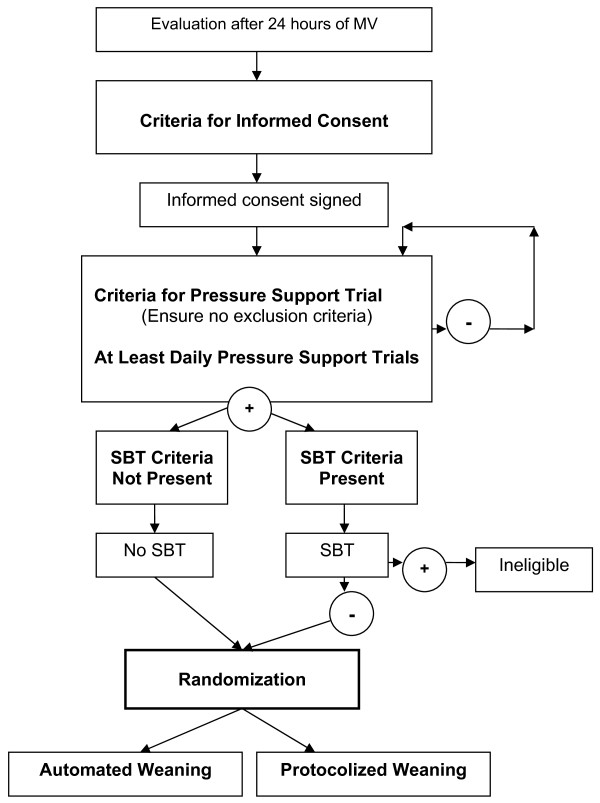
Study Flow Diagram.